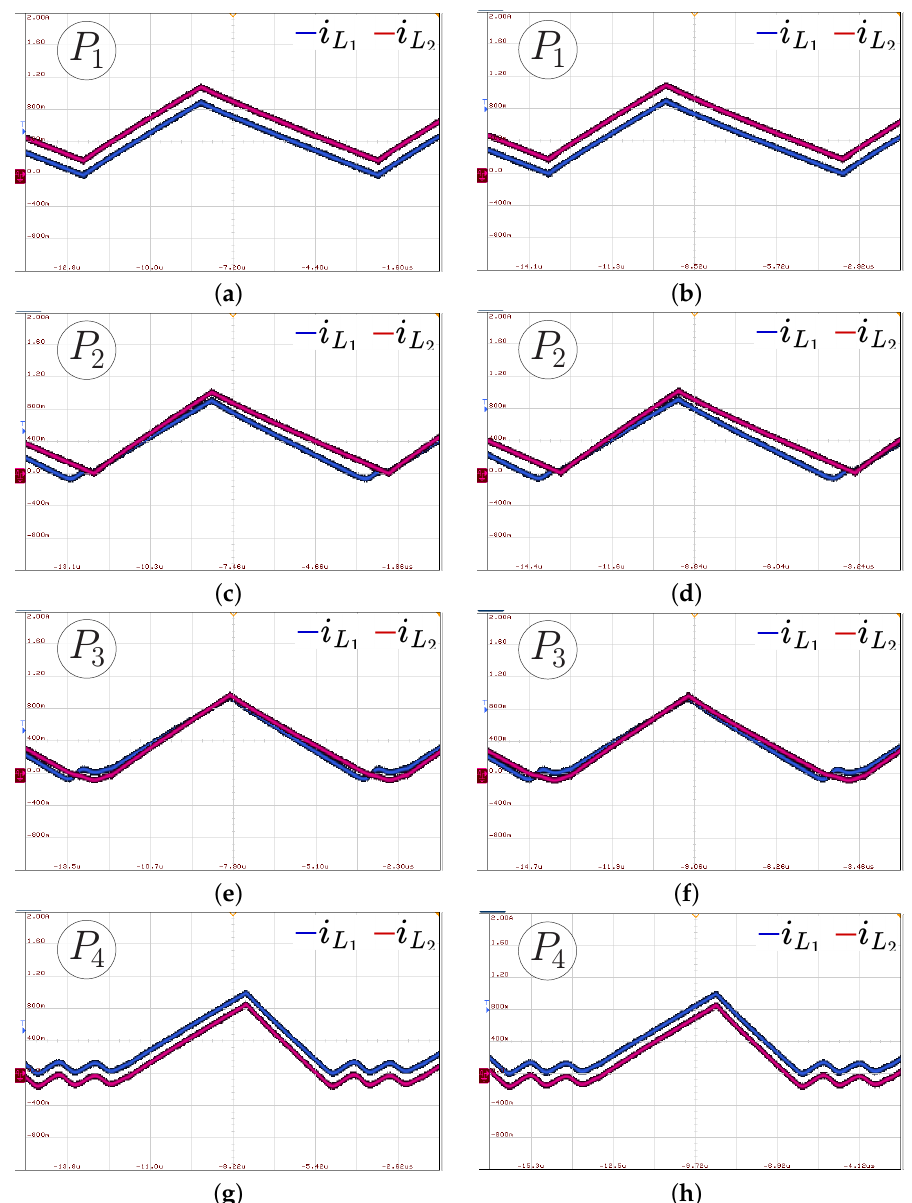
Figure 14. Inductor current waveforms in the open-loop control with a duty cycle of 0.4: ( a ) SEPIC in point P 1 , ( b ) ´Cuk in point P 1 , ( c ) SEPIC in point P 2 , ( d ) ´Cuk in point P 2 , ( e ) SEPIC in point P 3 , ( f ) ´Cuk in point P 3 , ( g ) SEPIC in point P 4 , and ( h ) ´Cuk in point P 4 , (400 mA/div, DC coupling, and a time base of 1.4 µ